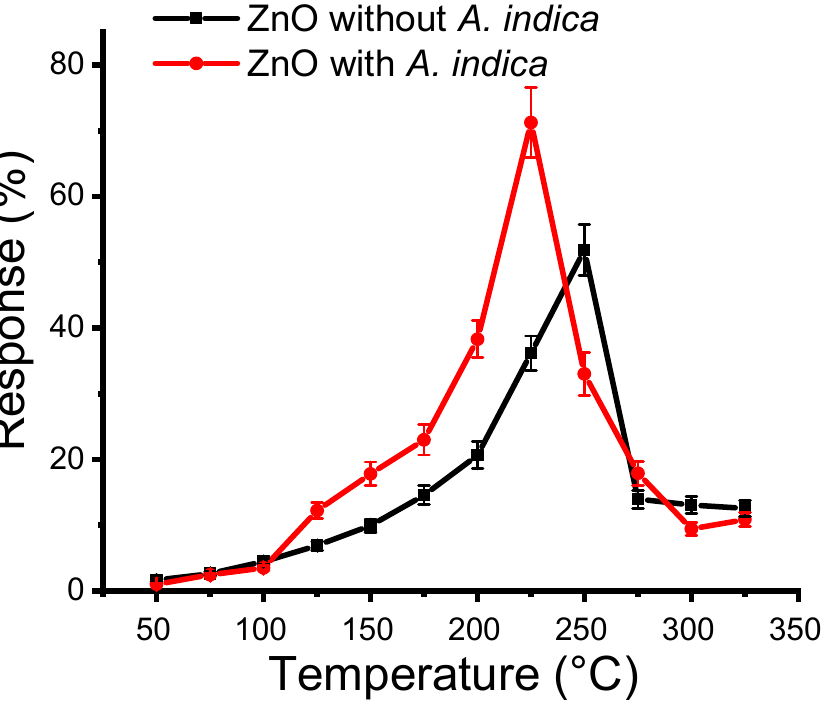
Figure 5. Response measurement as a function of temperature for ZnO thin films without and with A. indica dye extracts for ethanol vapor.